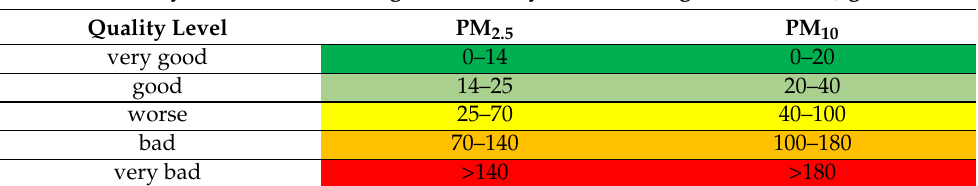
Table 1. Evaluation of air quality in measurement of particulate matter (according to Slovak Hydrom- eteorological